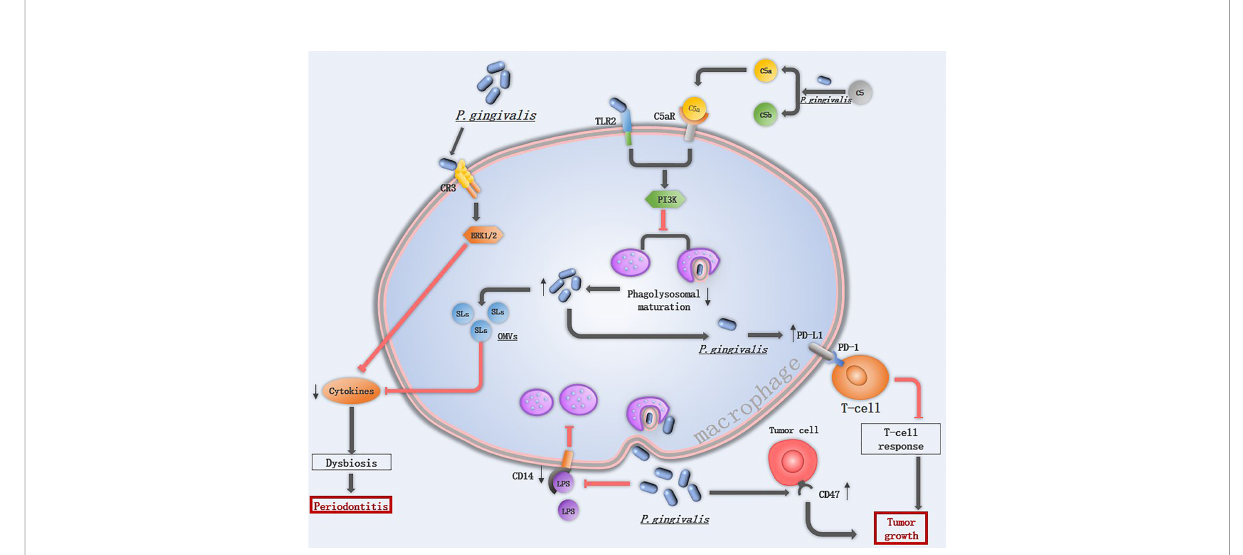
FIGURE 3 The mechanism of P. gingivalis in suppressing macrophage immune response: Extracellular P . gingivalis increases CR3 activation in macrophages while breakdowns C5 into C5a. The interaction of P. gingivalis with CR3 activates ERK 1/2, which reduces the cytokines level. The hemagglutinin/adhesion domain of gingipains cleave the LPS receptor CD14 from the surface of macrophages, resulted in a lower ability to phagocytize bacteria. The PD-L1 in macrophages is upregulated by P. gingivalis , which binds to PD-1 on T-cells and inhibits T-cell immune surveillance. CD47 is a phagocytosis inhibitor expressed on almost all cancer cells, it is regulated by P. gingivalis and protects cancer cells for macrophage phagocytosis. Once P. gingivalis enters into macrophages, intracellular P. gingivalis secretes OMVs containing SLs reduce the levels of pro-in fl ammatory cytokines, and initiates C5aR-TLR2 crosstalk signaling, activate the downstream PI3K pathway to suppress phagolysosomal maturation, avoiding being